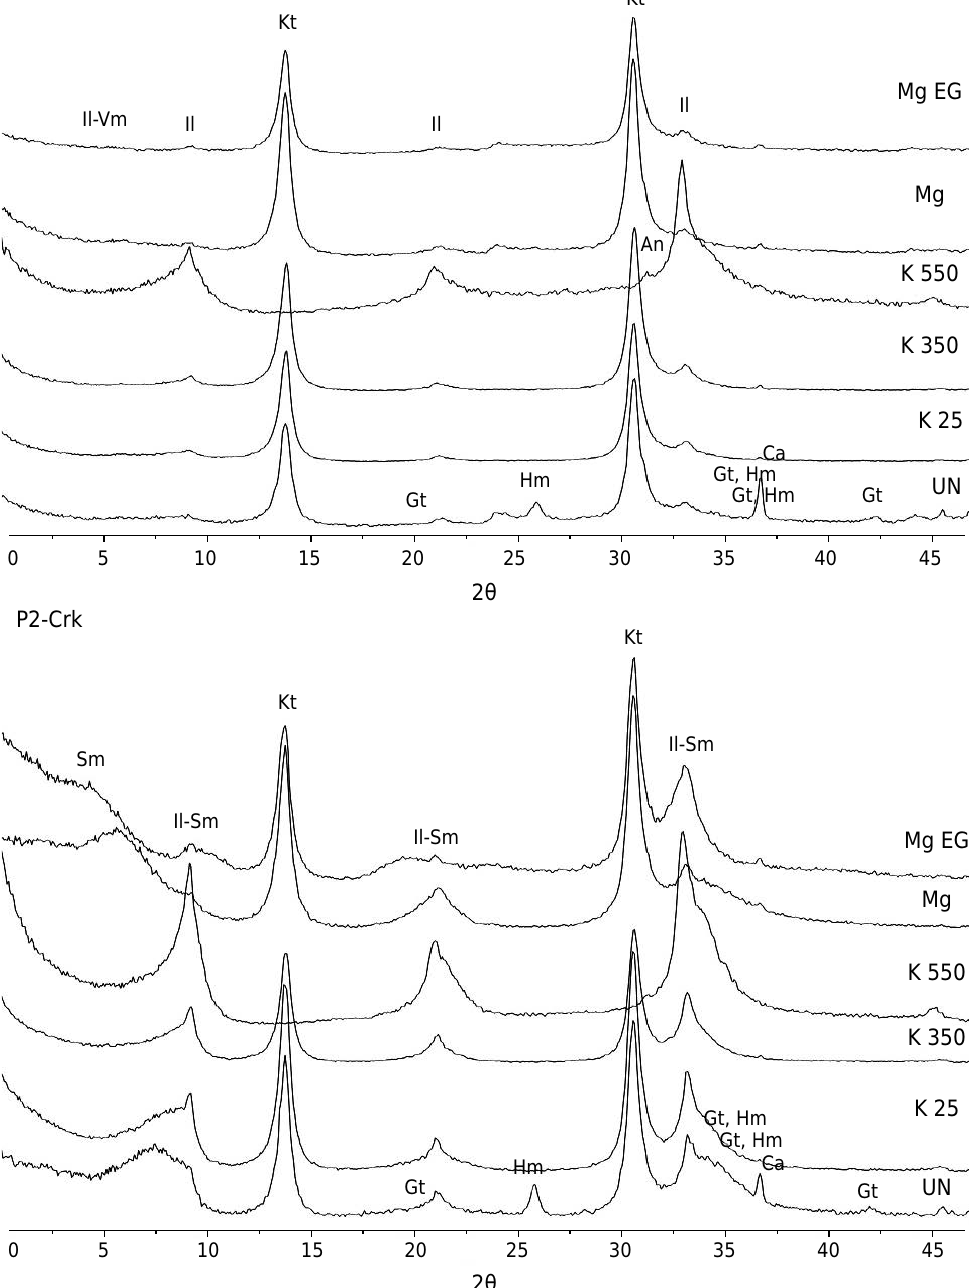
Figure 3. Diffractograms of the clay fraction of soil profile 2 (P2), Bcmќ and Crk horizons. Calcite (Ca), Smectite (Sm), Illite (Il), Kaolinite (Kt), Goethite (Gt), Hematite (Hm), Vermiculite (Vm), Anatase (An). Untreated total sample (UN), iron-free sample saturated with magnesium (Mg) and solvated with magnesium and ethylene-glycol (MgEG), iron-free sample saturated with potassium at room temperature (K25), and after heating at 350 °C (K350) and 550 °C